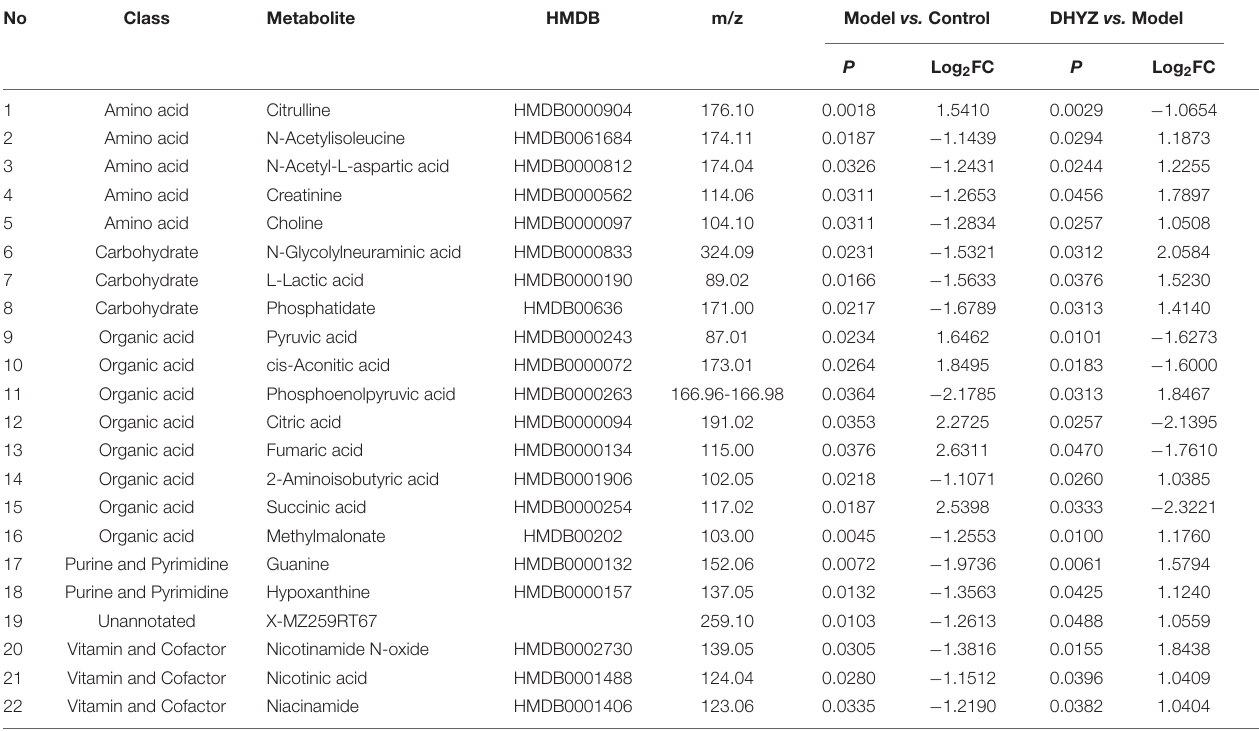
TABLE 3 | Differential metabolites in the urine of 2 × Tg-AD mice treated by